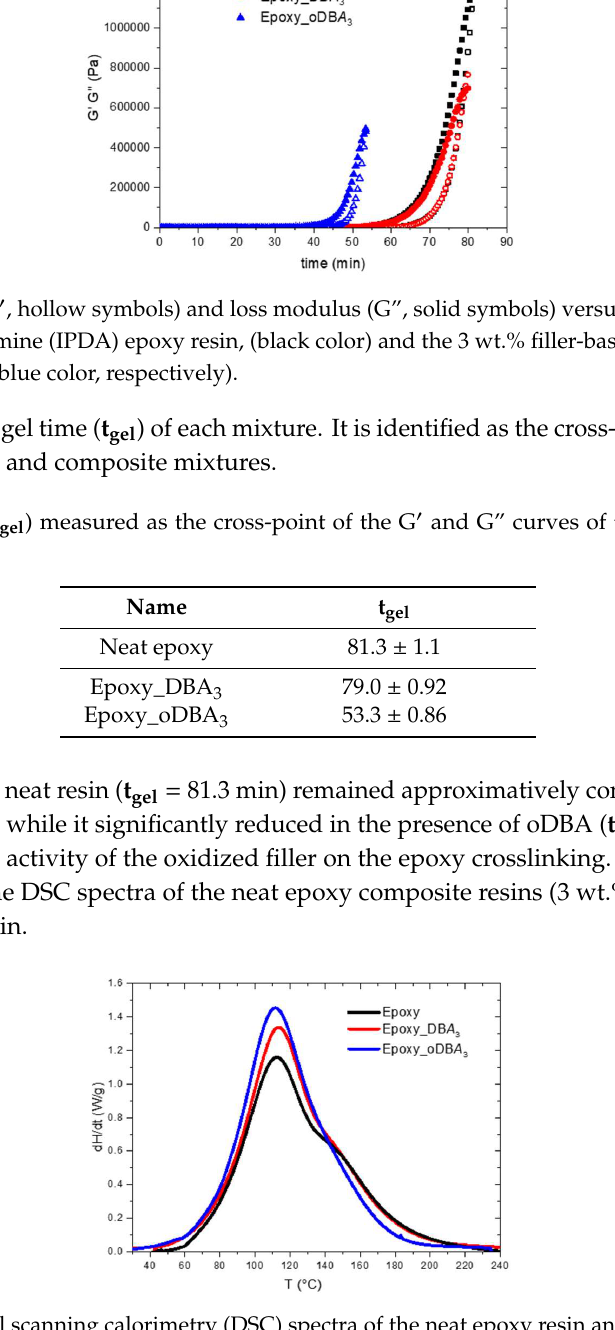
Figure 3. Di ff erential scanning calorimetry (DSC) spectra of the neat epoxy resin and composite resins with 3 wt.% DBA and oDBA.